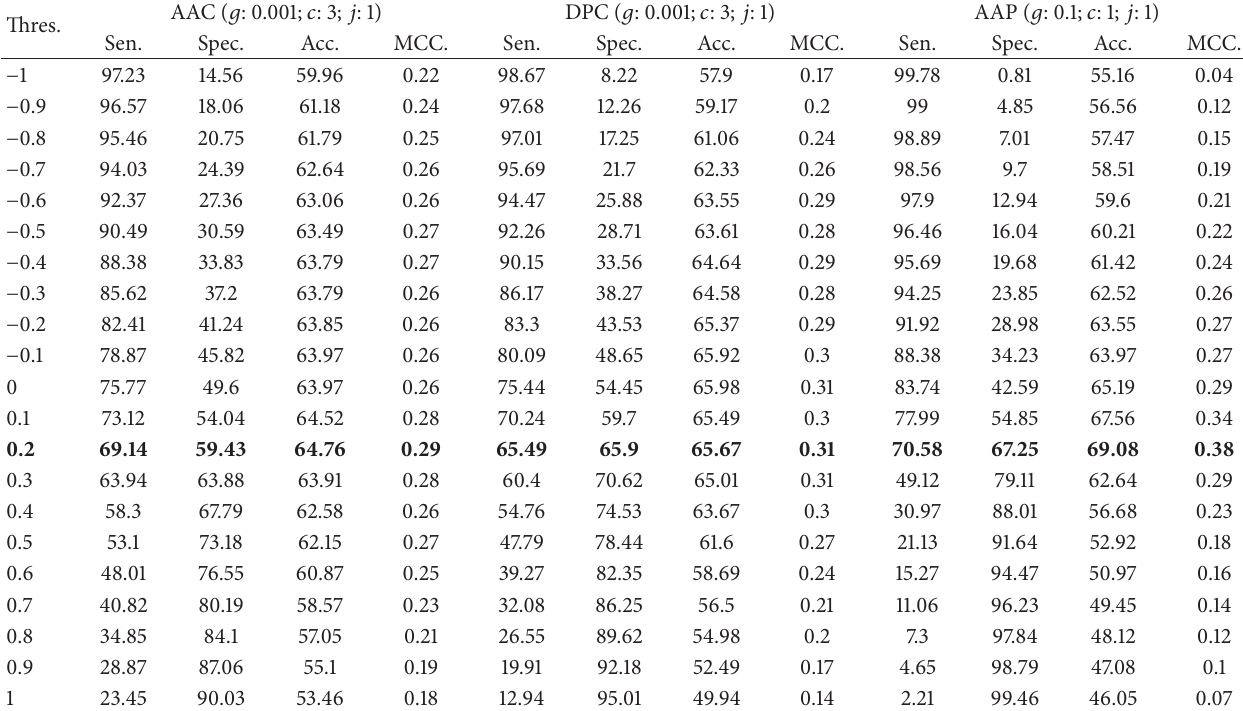
Table 3: The performances of SVM models developed using various compositional features of peptides on rbf-kernel. The optimized parameters have been given in the brackets.